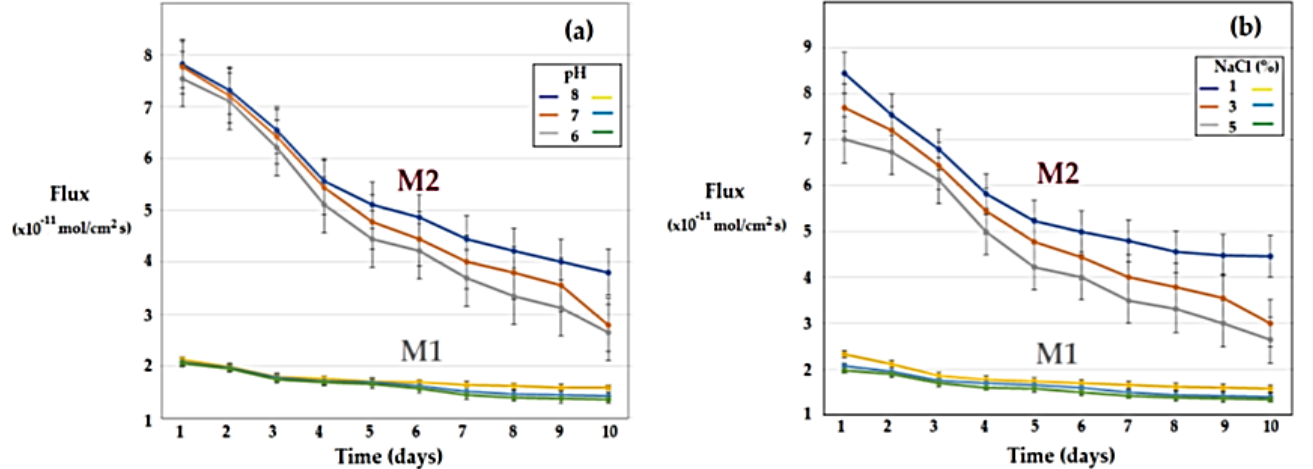
Figure 13. Time variation of melatonin flow through sulfonated ethylene-propylene-diene terpoly- mer (sEPDM) membranes (M1) and chitosan-sulfonated ethylene-propylene-diene terpolymer (Chi- sEPDM) membranes (M2), depending on pH ( a ) and salinity ( b ).